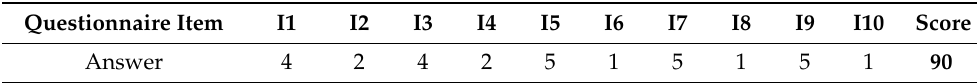
Table 7. SUS test therapist results.